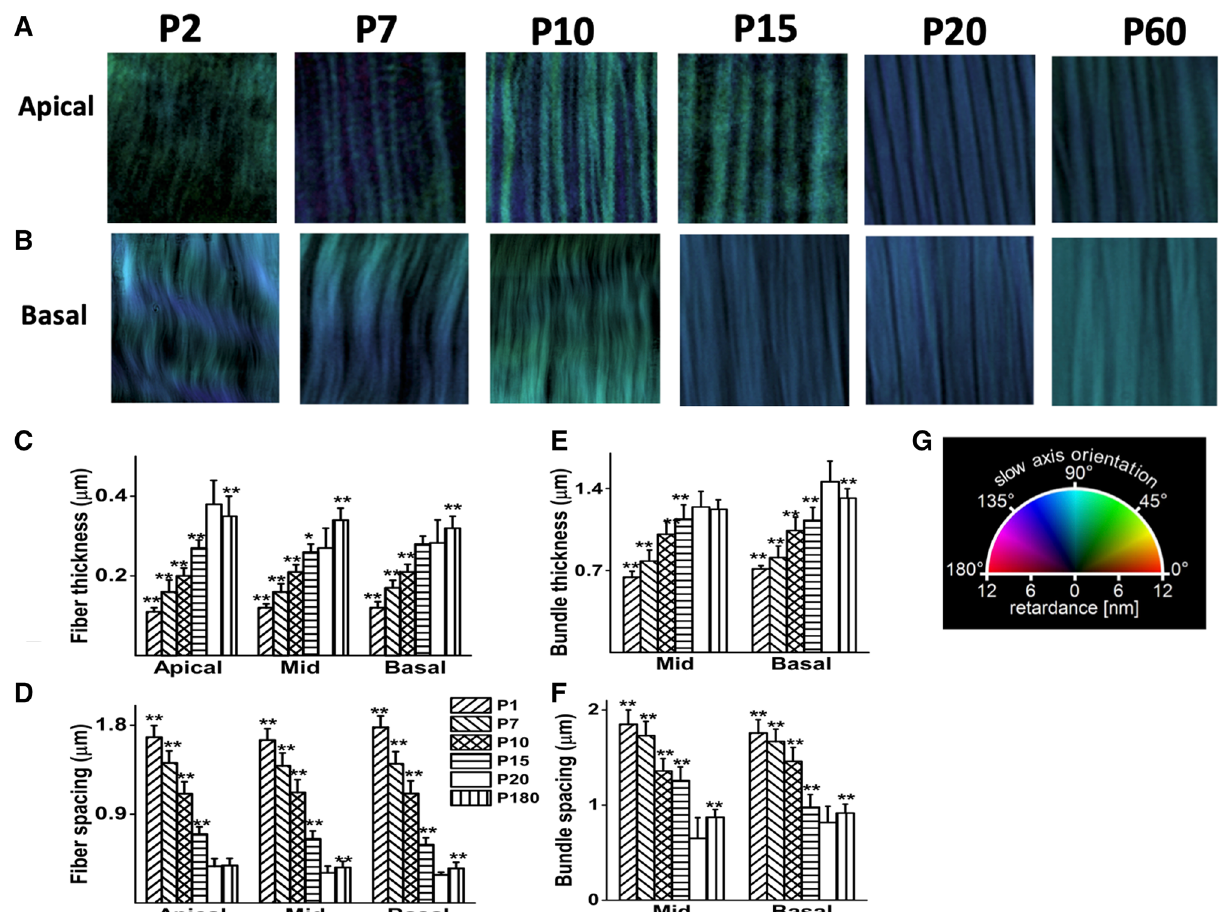
Figure 2. Changes in BM structure at different stages of development. ( A ) Examples of LC-PolScope images of collagenous fibers in unfixed BM preparations at P2, P7, P10, P15, P20 and P60 from apical turns of the cochlea corresponding to the ~ 7 kHz region, corresponding to location about 90% of BM length, with base being 0% and apex 100% 42 . Sample size shown is 10 × 10 μm. ( B ) Examples of LC-PolScope images of collagenous fibers in unfixed BM preparations at P2, P7, P10, P15, P20 and P60 from basal turns of the cochlea corresponding to the ~ 60 kHz region, corresponding to location about 10% of BM length, with base being 0% and apex 100% 42 . Sample size shown 10 × 10 μm. ( C ) Fiber thickness in apical, midturn and basal regions of BM all increase significantly (as indicated by asterisks, see below) in size with age to P20 (as indicated by different column hatchings, see key for postnatal ages P1 to P60), but not significantly between P15 and P20 in cochlear basal turn. Fiber thickness continues to increase with age to P60 in mid and basal turns and decreases in apical turns. ( D ) Fiber spacing decreases with postnatal age to P20 in the BM apical, midturn and basal regions and increases significantly between P20 and P60 in the mid and basal turns. ( E ) Bundle thickness increases with age to P20 in the BM midturn and basal regions. Bundles were not observed in apical turns. Bundle thickness decreases significantly between P20 and P60 in the basal turn. ( F ) Bundle spacing in the BM midturn and basal regions decreases with age to P20 and increases from P20 to P60. ( G ) Color wheel shows a visual vectorial representation of orientations. A color wheel correlates the pseudo colors and the optical axis orientation. The reference (zero degrees) is the longitudinal axis of basilar membrane or X axis when you align the images of fibers along Y axis. Similar fiber colors indicate uniform alignment; color variations indicate nonuniformity in alignment. The measurements used for ( C )–( F ) were derived from measuring 200 samples for each age and location, using BM samples from six cochleae (3 mice) per age group, means ± SD. , * p < 0.001 and ** p < 0.0001, two-tailed unpaired t test comparing measurements taken at different ages with